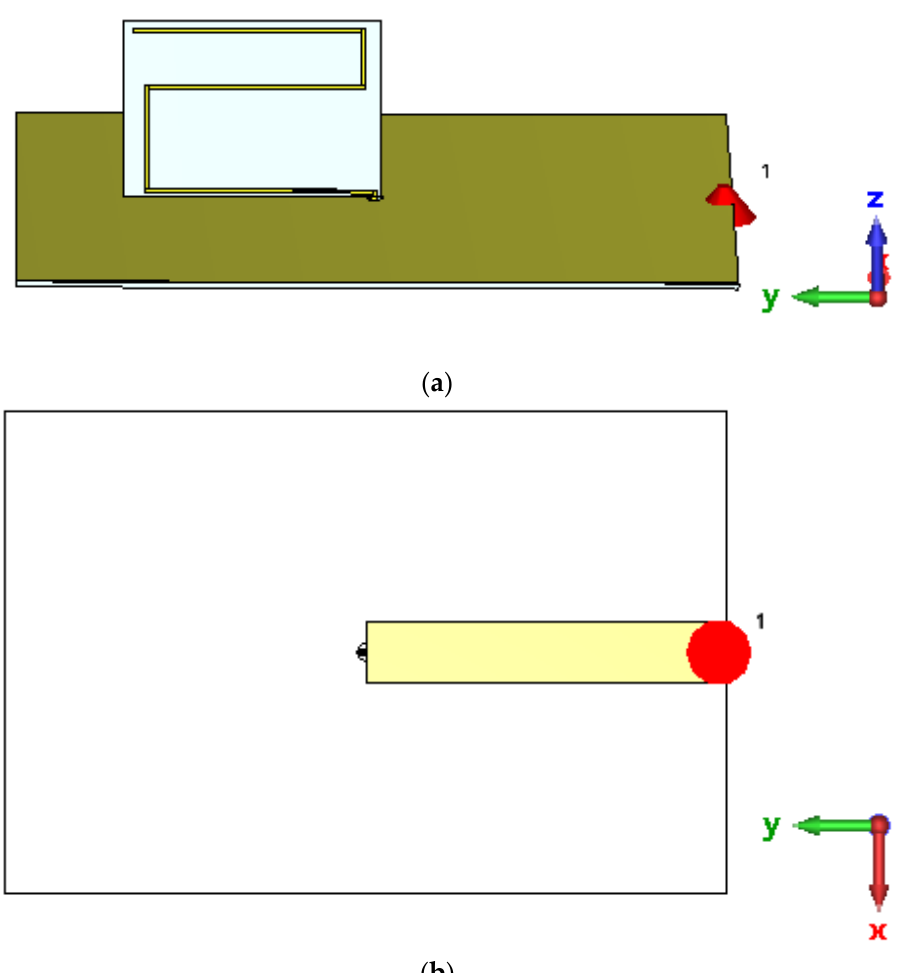
Figure 15. Simulation model of the meander line monopole antenna with an impedance matching circuit: ( a ) Overview; ( b ) Bottom view.